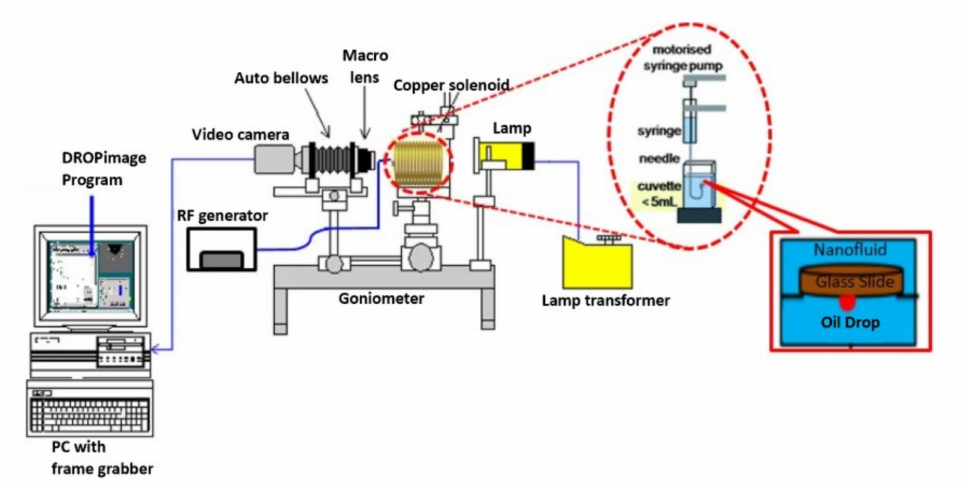
Figure 1. Goniometer is attached with an Electromagnetic source for the measurement of interfacial tension (IFT) and contact angle; source: Adil et al.